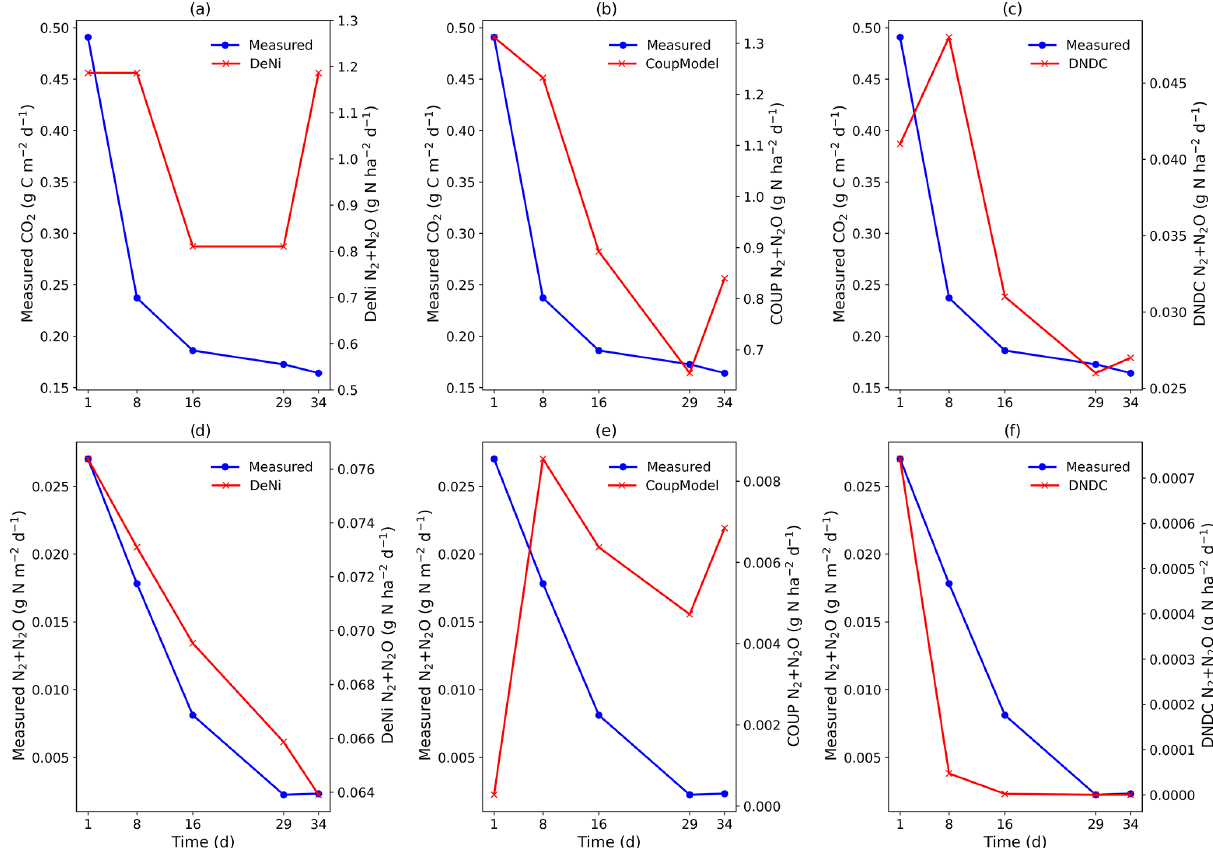
Figure 1. (a–f) An example (treatment VI) for the measured and modeled (DeNi, Coup and DNDC) CO 2 (a–c) and N 2 + N 2 O (d–f) fluxes of a silt-loam arable soil from Hattorf,